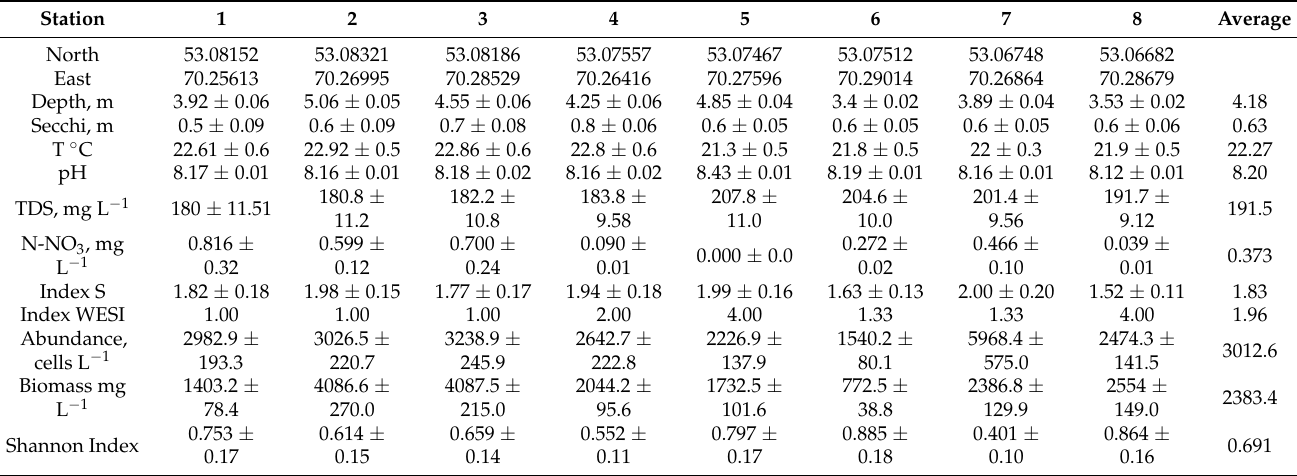
Table A1. Averaged environmental variables with standard deviation and coordinates of sampling stations on the Lake Borovoe, 2019.